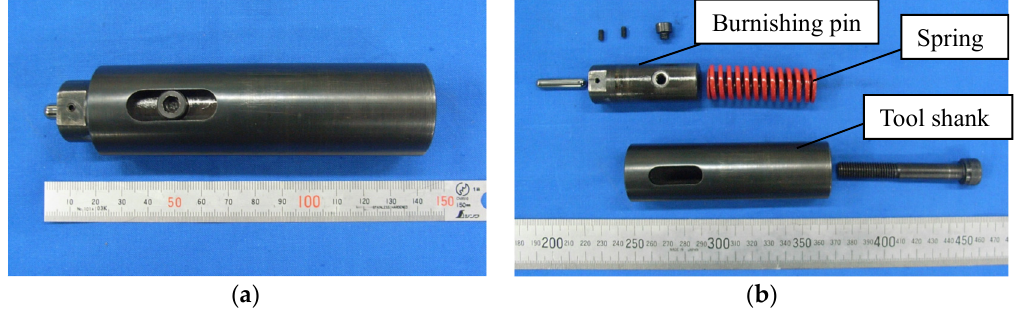
Figure 2. Tool for friction stir burnishing (FSB): ( a ) External view; and ( b ) Components.